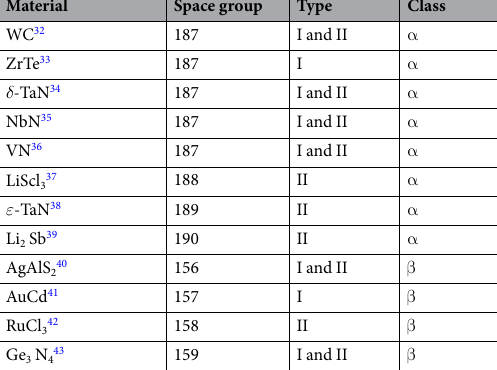
Fig. 3c, the two-fold degeneracy between the ψ ′ and ψ ′ bands is lifted. As a result the doubly-degenerate (blue) 1 2 band splits into two singly-degenerate bands, each of which crosses with the third band to form a Weyl node. Therefore, each triply-degenerate fermion splits into a pair of Weyl nodes with opposite chiral charge. We point out a number of key distinctions between the Dirac semimetal and the new TM cases. First, in a Dirac semimetal, the immediate pair of Weyl nodes that emerge from the same Dirac node (e.g., − W and + W in Fig. 3b) arise from 1 1 crossings between the same two bands (the yellow and red bands). By contrast, in the new TM, the pair of Weyl nodes that emerge from the same triply-degenerate node (e.g., − W and + W in Fig. 3d) arise from the crossings 1 2 between three different bands. Specifically, − W is due to the crossing between the black and the yellow bands 1 whereas + W is due to the crossing between the yellow and the red bands. As a result, the energy-momentum 2 region with nonzero Chern number (the blue shaded area) in the new TM is drastically different from that of in a Dirac semimetal and spans across all k z . Figures 3e,f further show how a triply-degenerate node splits into a pair of Weyl nodes under a Zeeman coupling, for the type-I and -II cases, respectively.